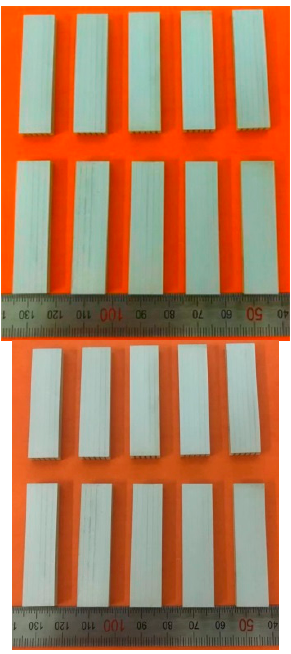
Figure 12. Image of the fabricated 2 ‐ 2 piezoelectric composites.